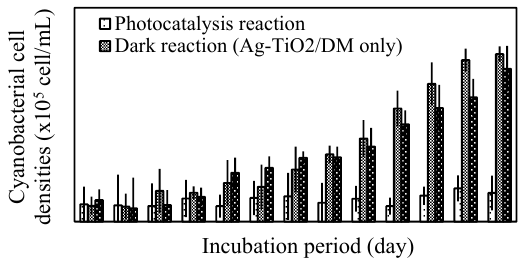
Figure 3. The concentrations of DOC as a function of photocatalytic reaction time in Microcystis aeruginosa suspensions.